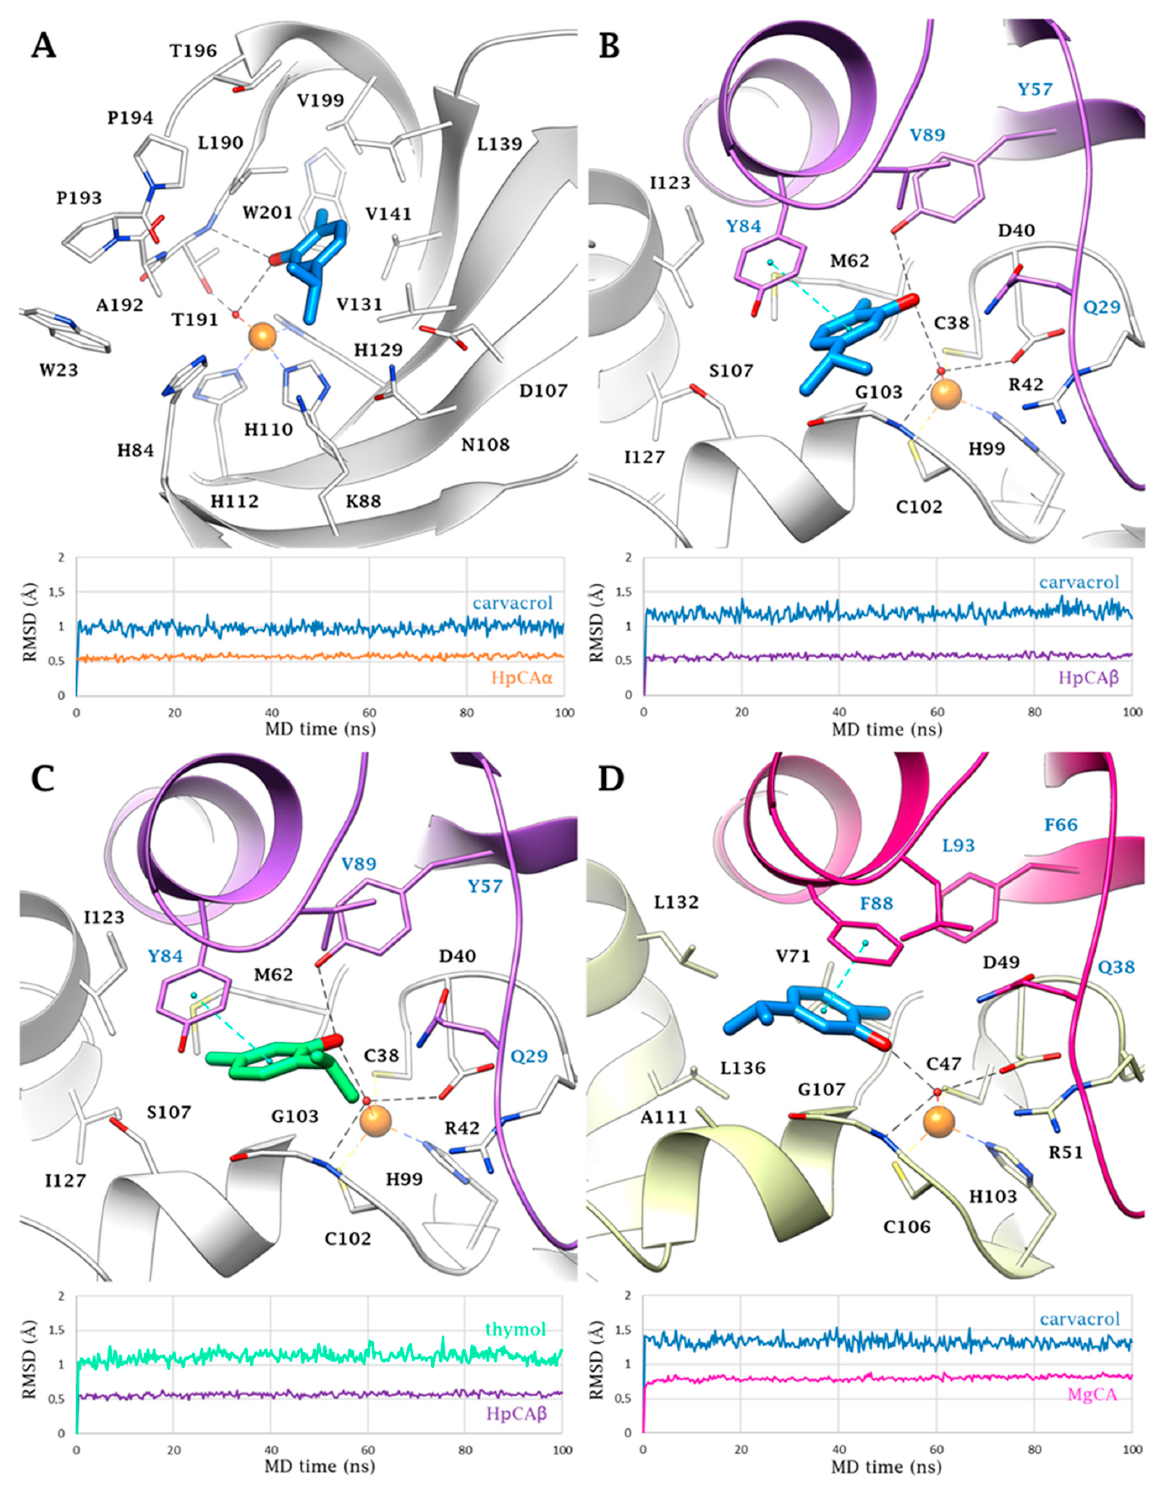
Figure 1. Ligand interactions within ( A ) HpCA α , ( B , C ) HpCA β , and ( D ) MgCA active sites. Carvacrol and thymol are represented in blue and green, respectively. Snapshots from the corresponding MD are shown in each panel together with the trajectories.